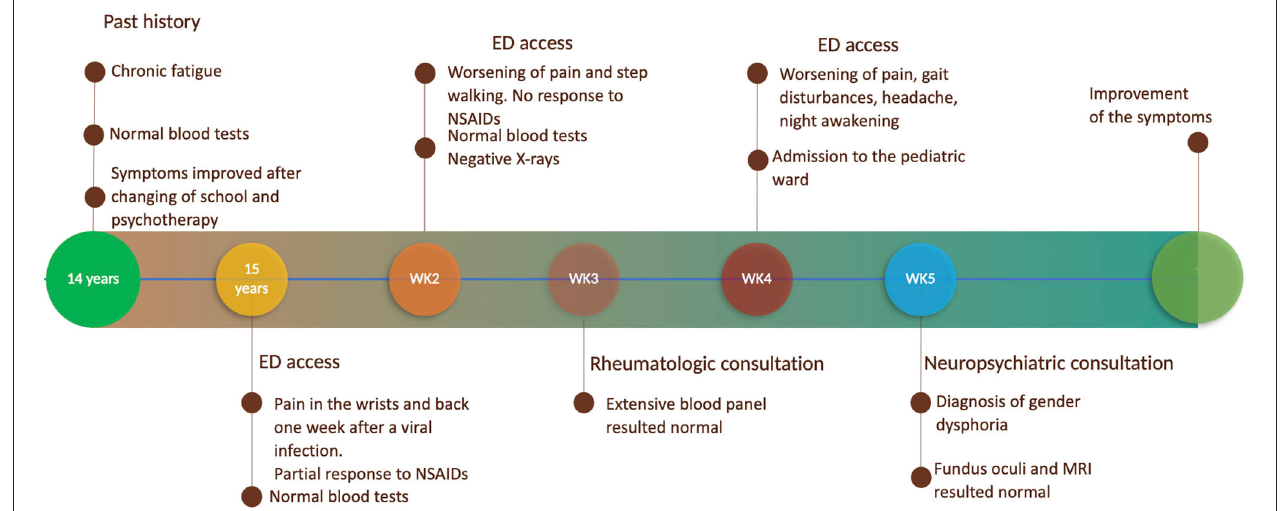
FIGURE 1 | Timeline with relevant data about the episode of